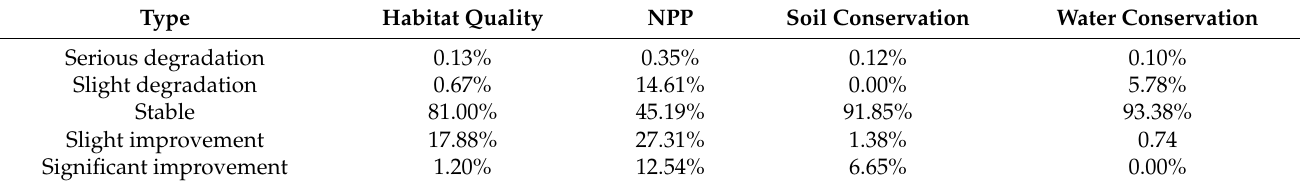
Table 3. Trends in the ecological system of the Yangtze River Delta urban agglomeration from 1980 to